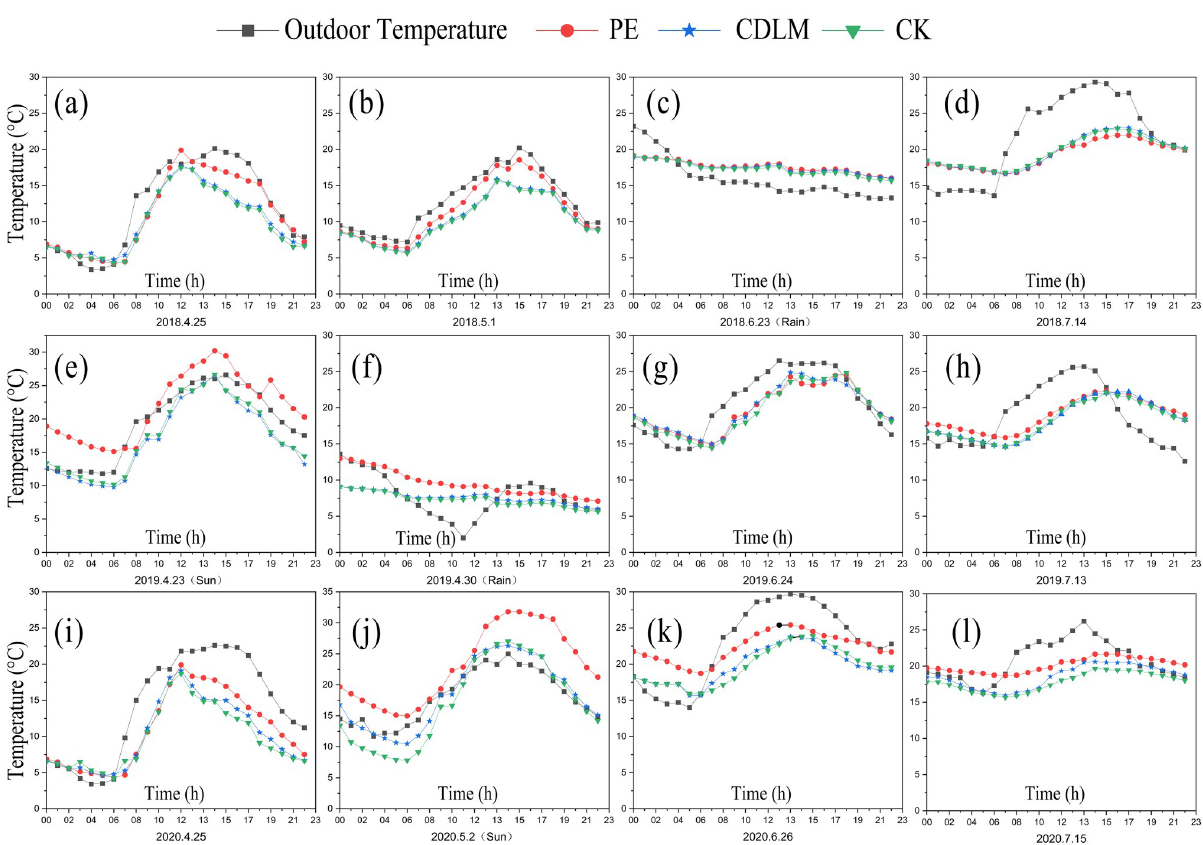
Fig 6. The outdoor temperature and soil temperatures of plots covered by CDLM, PE films, and CK recorded at every 1 h within 24 h at a certain day in the critical stages of ST, VE, V9 and V12 in 2018, 2019 and 2020.